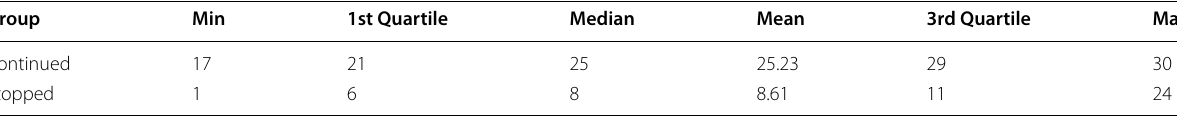
Table 5 Descriptive statistics of the length of treatment per treatment